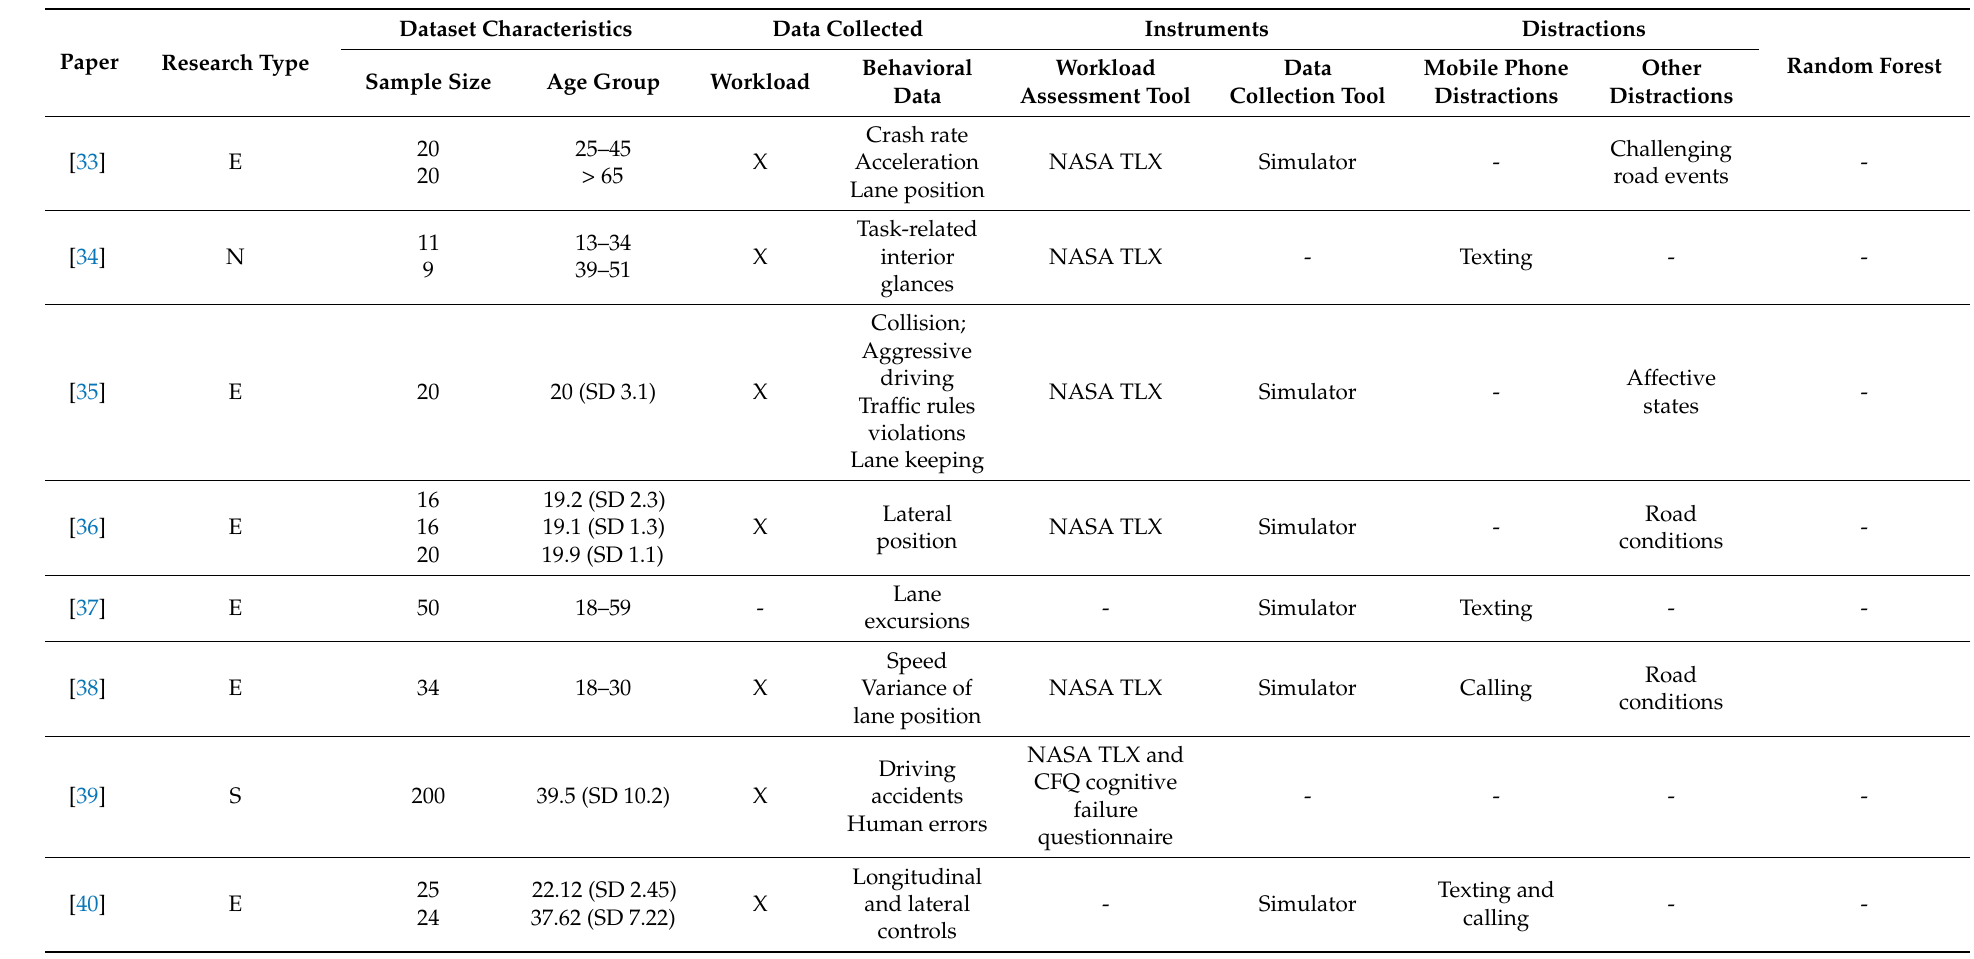
Table 1. Summary of similar past